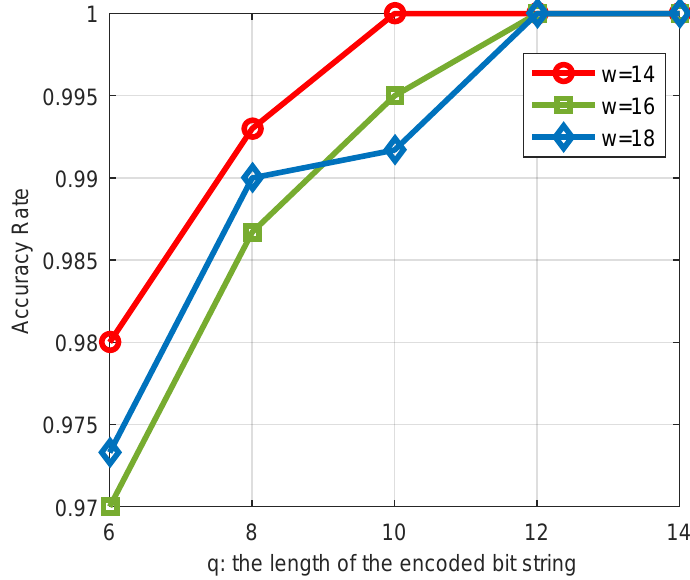
Figure 4. Accuracy rate of estimated data influenced by the value of q , where n =